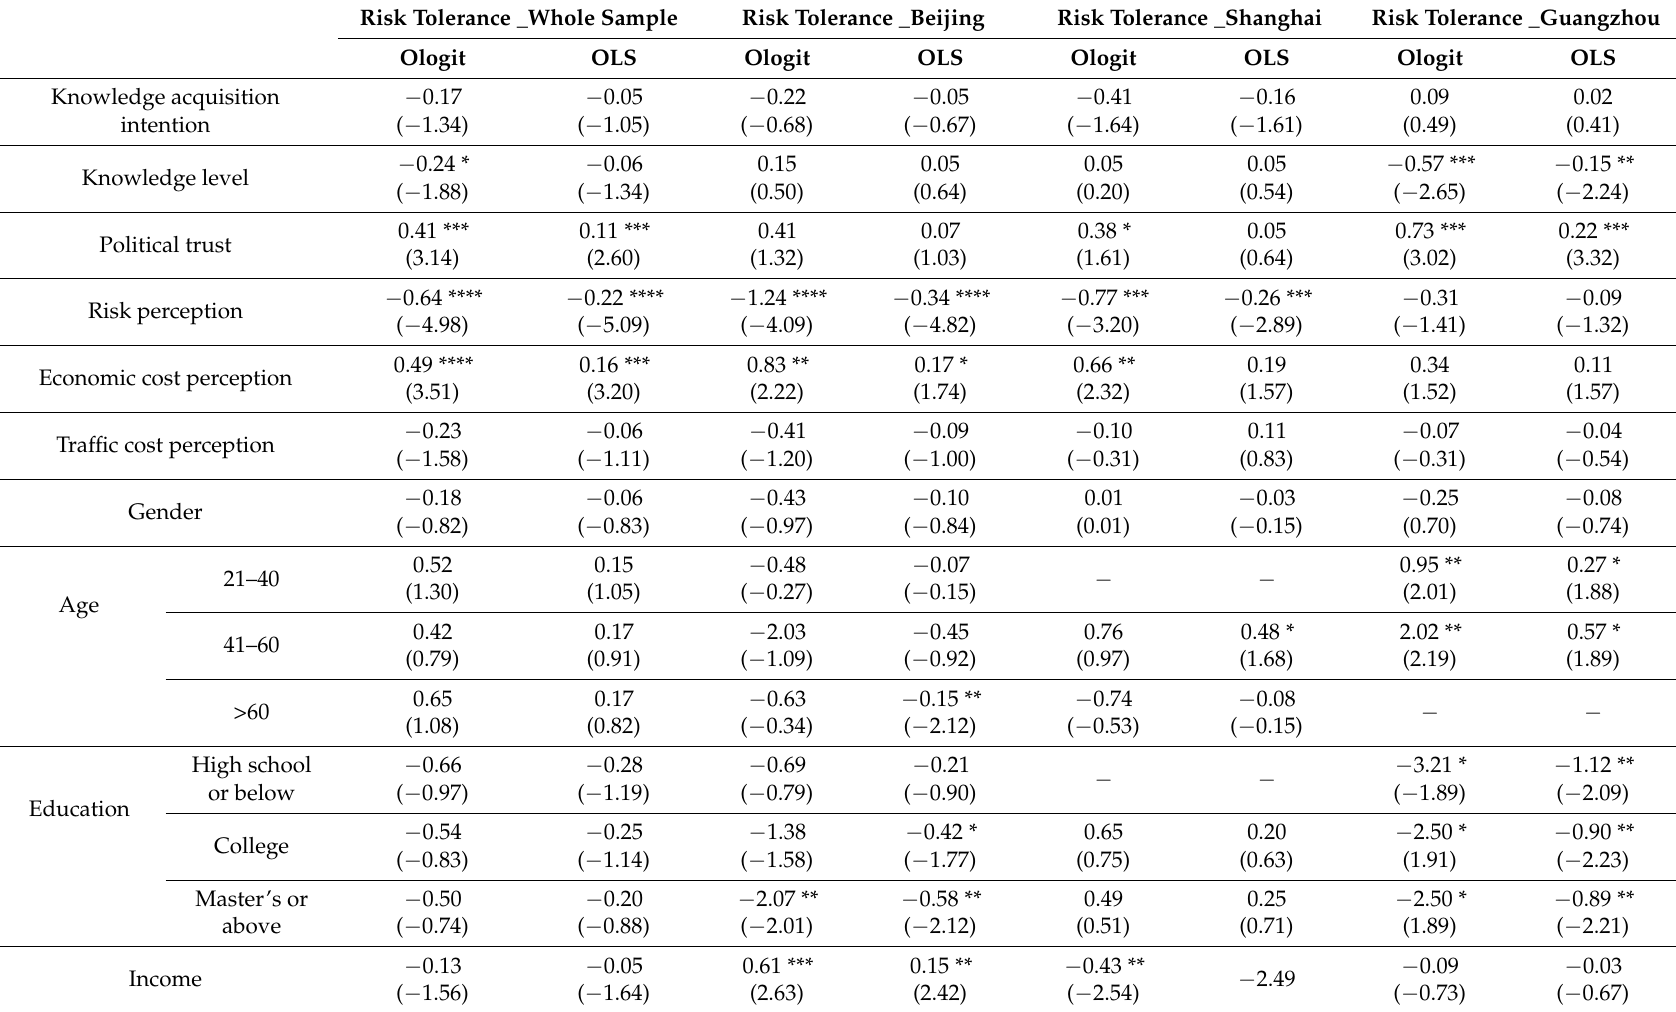
Table 13. Influencing mechanism of haze